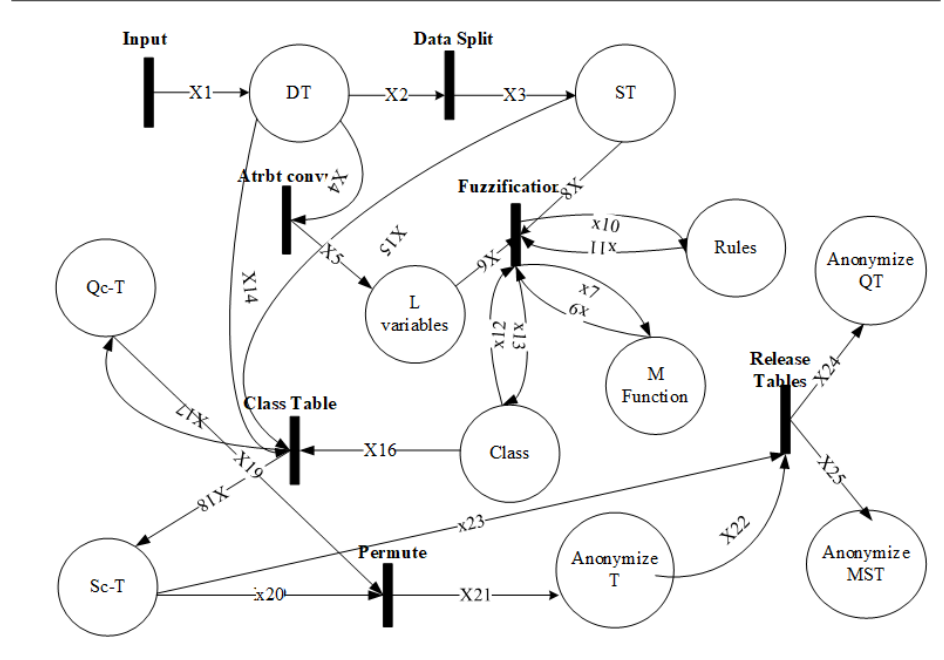
Figure 3. HLPN for F-Classify